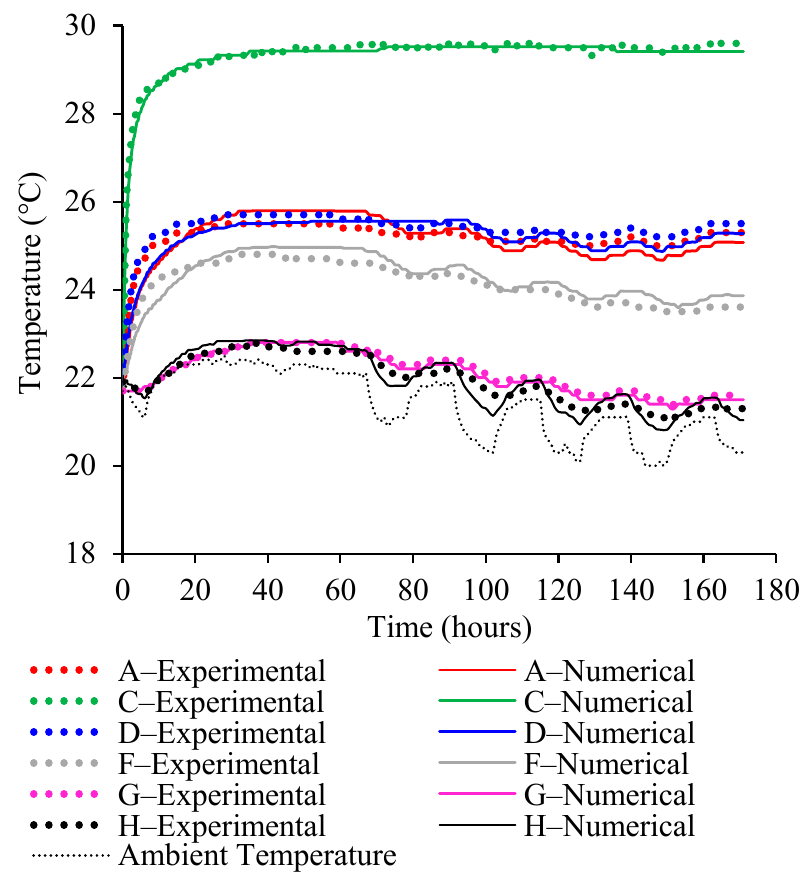
Figure 7. A comparison of the results of the experimental and numerical investigations for the dry sand.